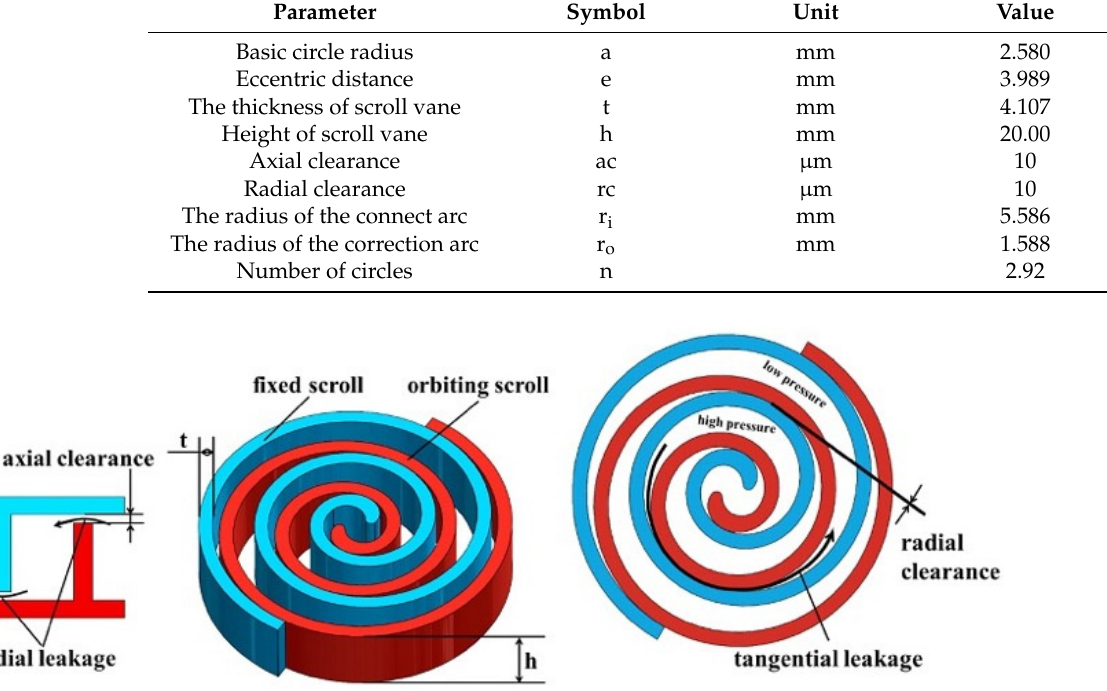
Table 1. The main parameters of the scroll compressor.